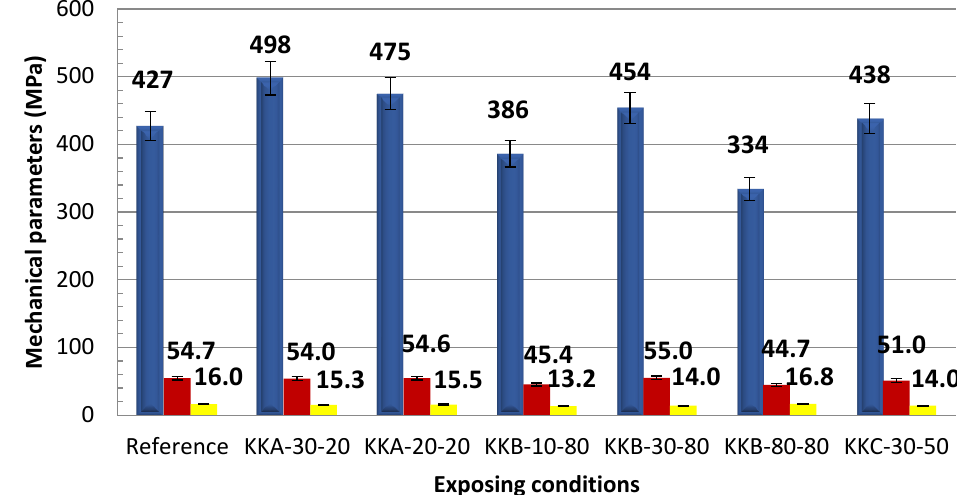
Figure 14. KKB-80-80 sample after tensile strength testing.